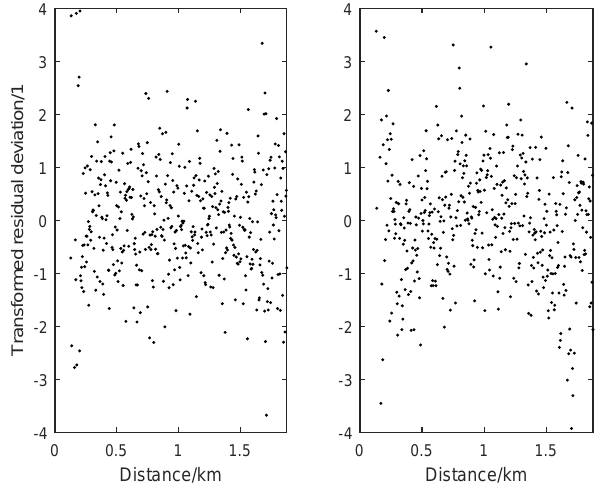
Figure 12. As Fig. 10 but for the results of the GLS approach shown in Fig. 11.